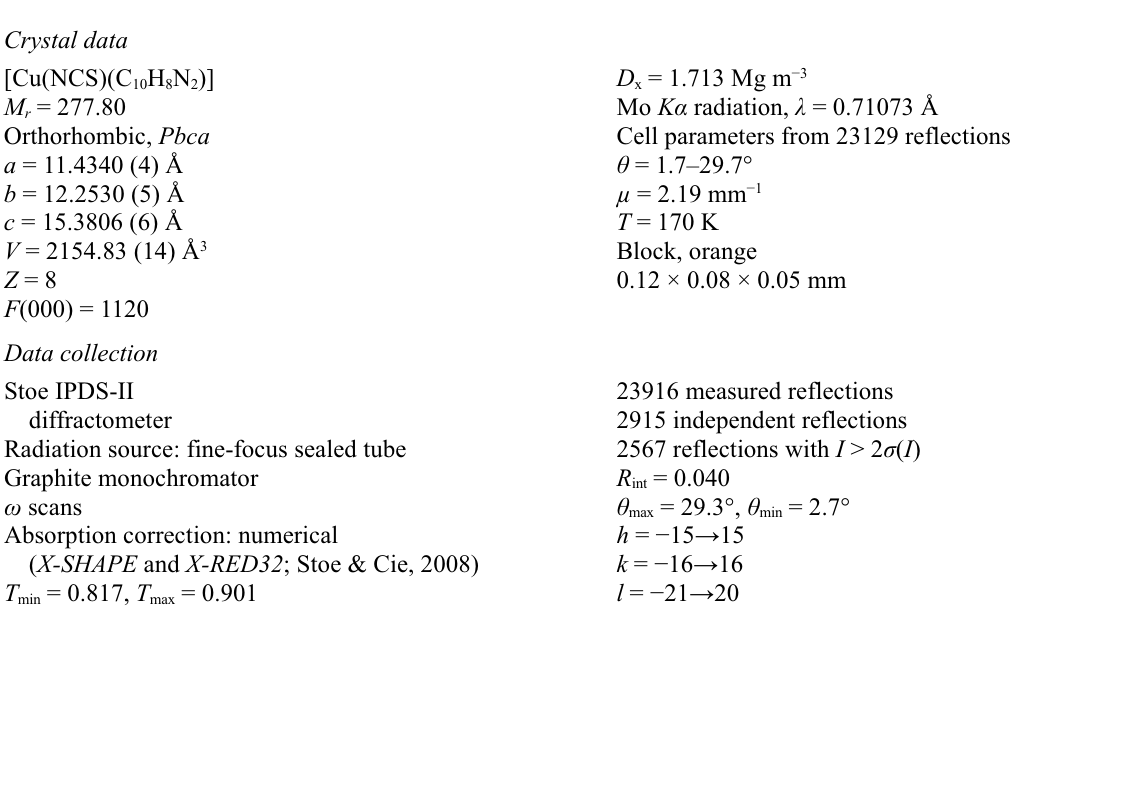
Figure 3 Crystal structure of the title compound with view along the a axis. Poly[ µ -4,4 ′ -bipyridine- κ 2 N:N ′ - µ -thiocyanato- κ 2 N : S -